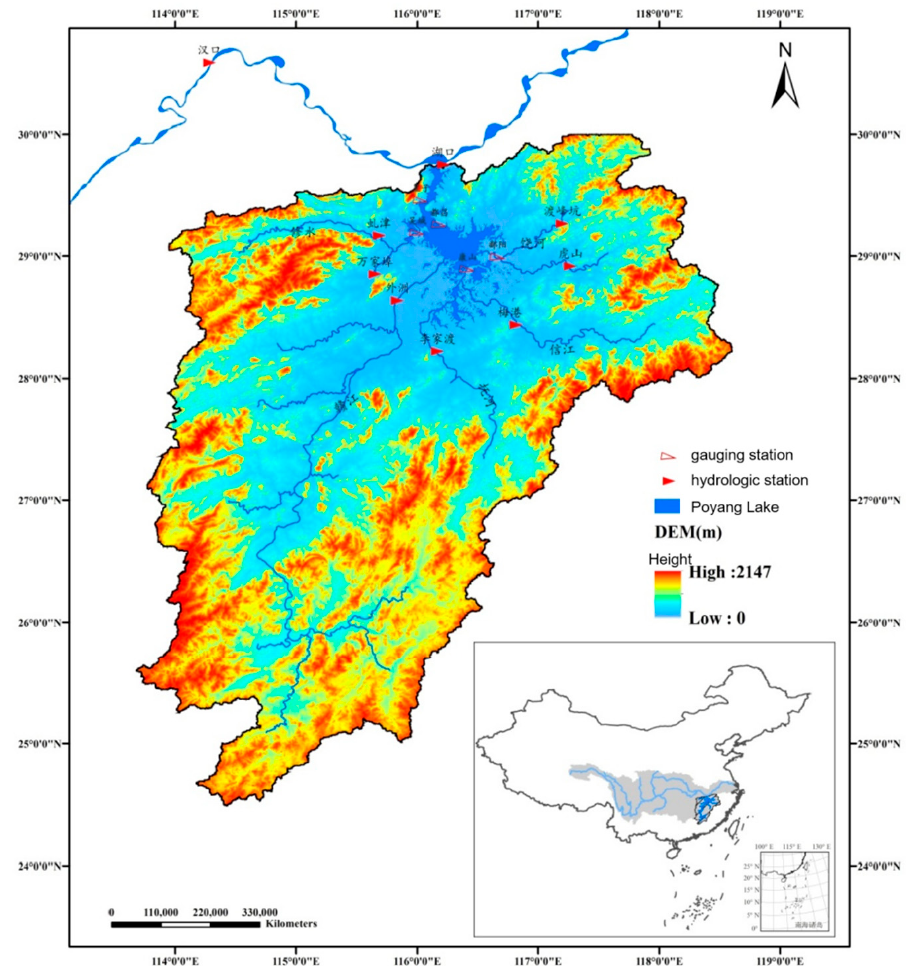
Figure 1. Location of the research